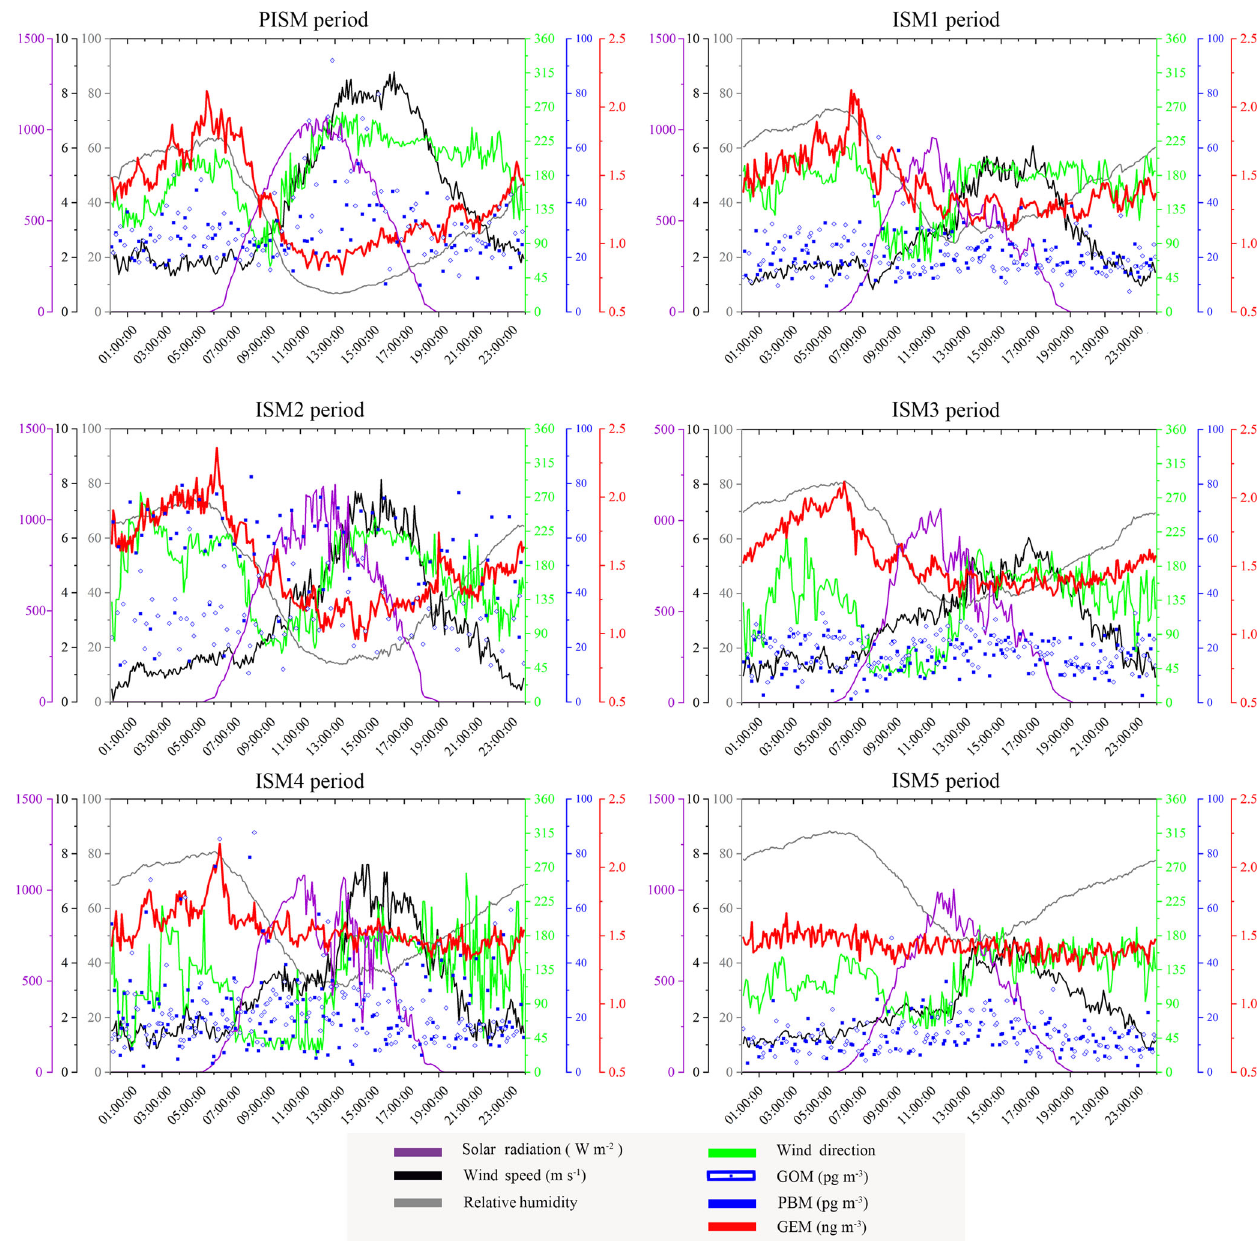
Figure 3. Diurnal variations of GEM, GOM and PBM concentrations during the pre-Indian summer monsoon (PISM) period and the five Indian summer monsoon (ISM) periods: 15–30 April 2016 (PISM), 1–12 May (ISM1), 13 May–4 June (ISM2), 5–20 June (ISM3), 21 June– 10 July (ISM4) and 11 July–14 August (ISM5). The concentrations represent the daily average values during each